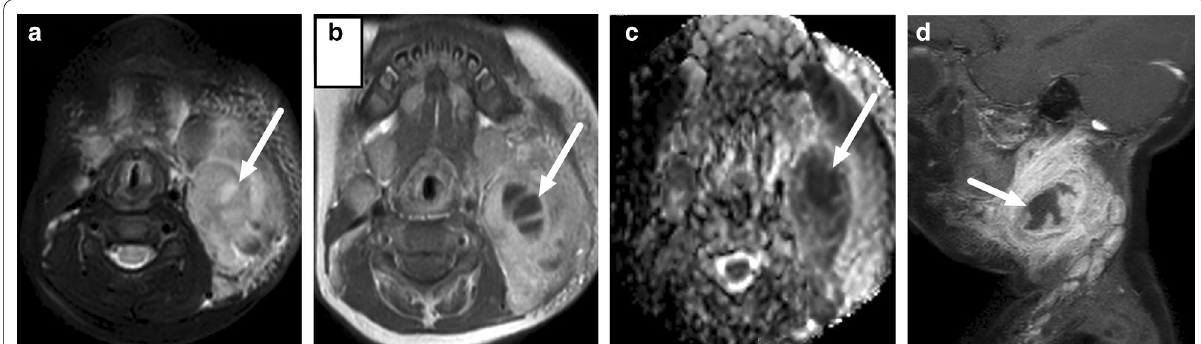
Fig. 22 Lateral superficial suppurative lymphadenitis in an infant. Lymphadenopathy and surrounding edema are shown on an axial fat-suppressed T2-weighted image ( a ), and a non-enhancing center on post-contrast axial ( b ) and fat-suppressed sagittal ( d ) T1-weighted images with low ADC ( c ) (arrows). Imaging was consistent with suppurative lymphadenitis. Purulence was found during surgery and Staphylococcus aureus in pus cultures. Image modified from ref.